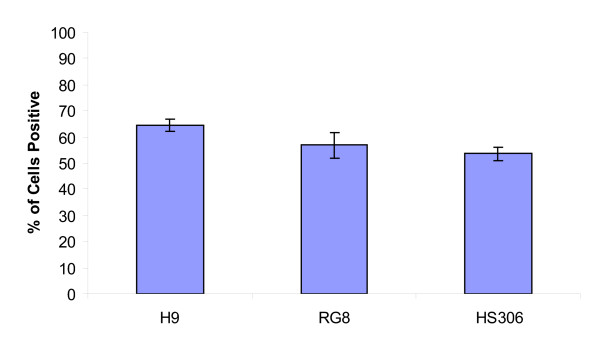
Multiple hESC lines are transfected efficiently. In addition to the H9 cell line, two hESC cell lines, RNJ8 and HS306, were also efficiently transfected, with resulting percentages of GFP-expressing cells greater than 50%.